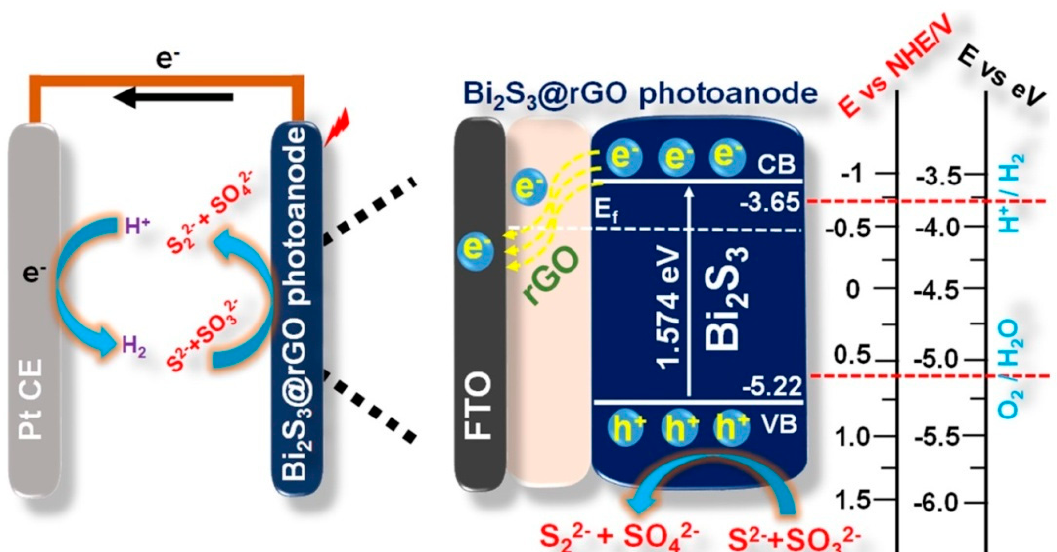
Figure 4. Schematic charge-transfer process in the Bi 2 S 3 @rGO composite photoanode under light illumination. [Reprinted with permission from reference [101]. Copyright 2021, American Chemical Society].